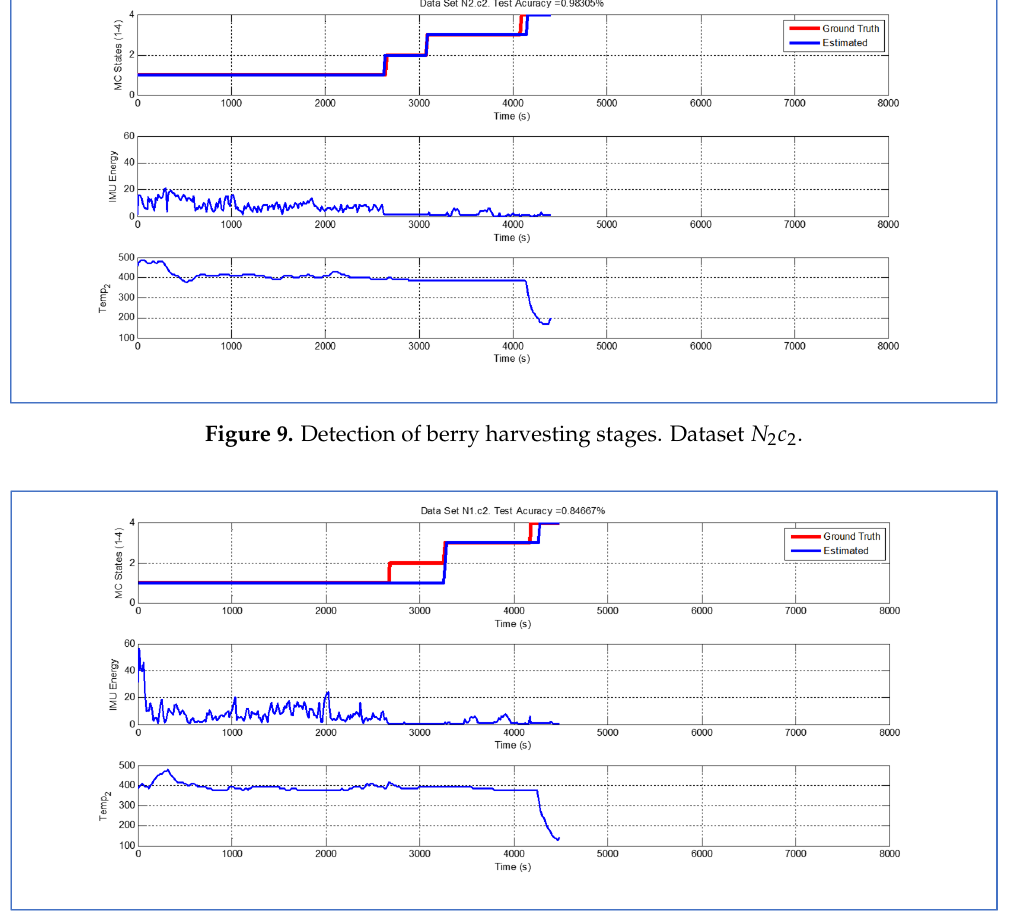
Figure 10. Detection of berry harvesting stages. Dataset N 1 c 2 .